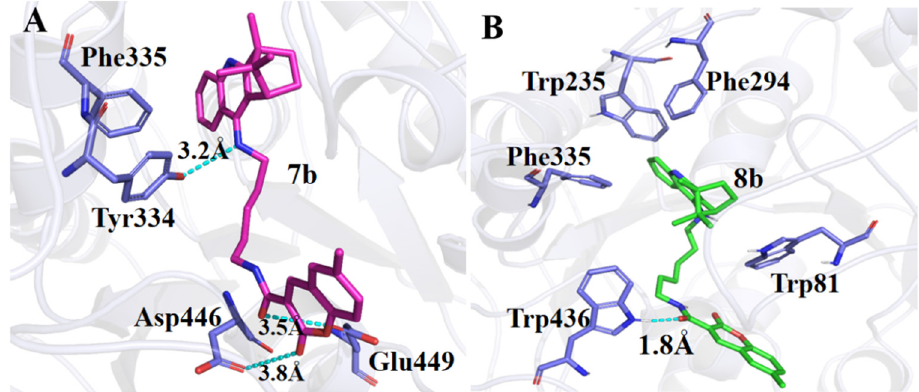
Figure 6. Binding mode of AchE (white cartoon) with the compounds 7b ( A ) and 8b ( B ). The blue dotted lines represent H-bonds. The interaction residues are shown as purple sticks, the compound 7b as a red salmon stick and the compound 8b as a green salmon stick.